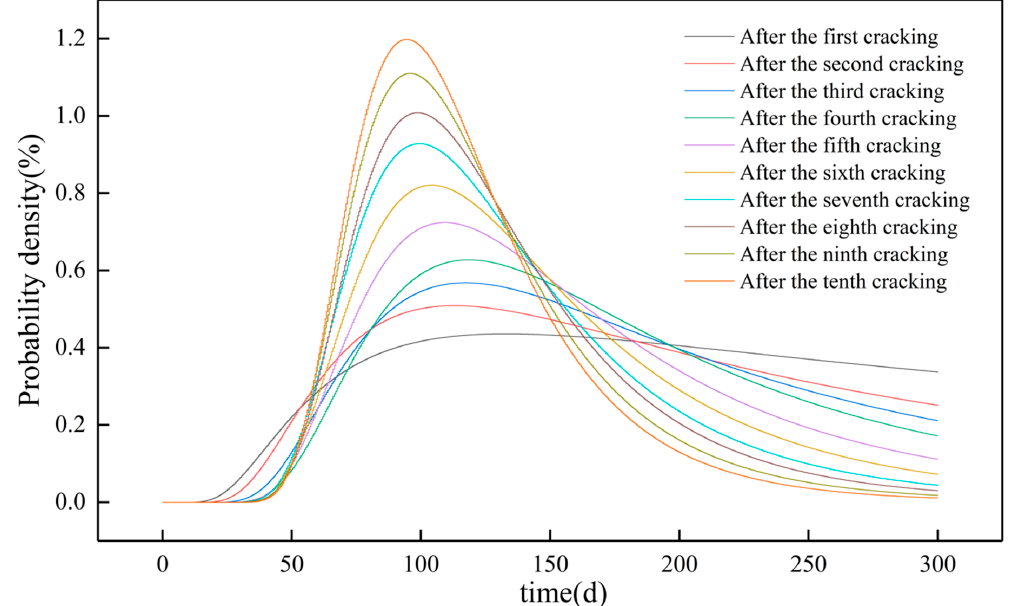
Figure 12. The progressively updated distributions of λ given the observed values of T AS .